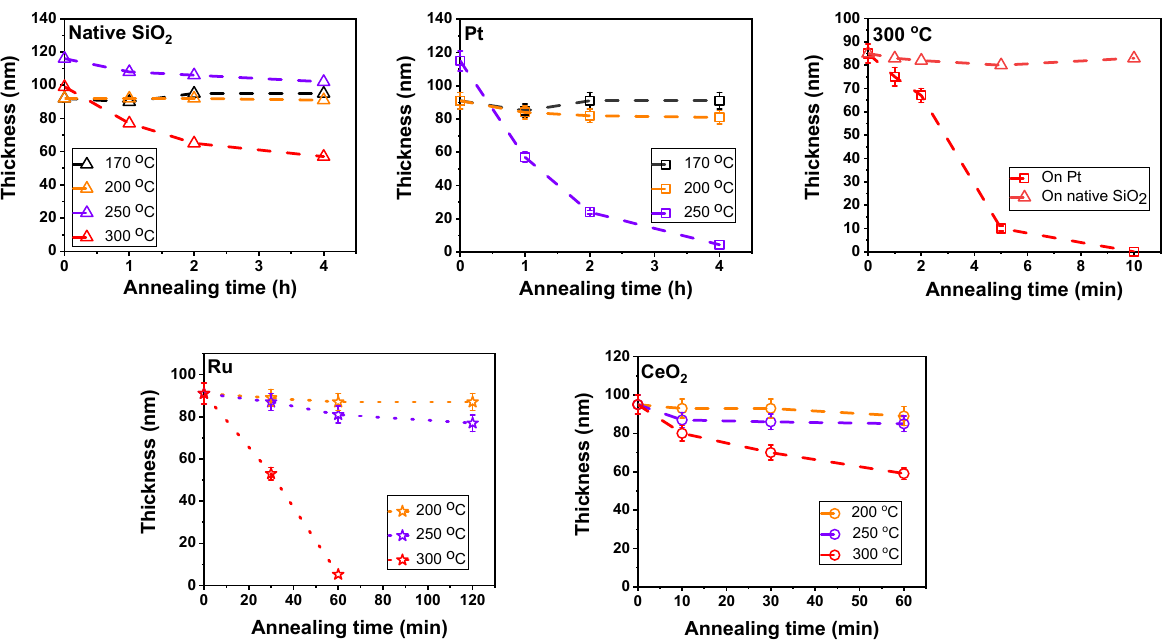
Figure 2. Polyimide film thicknesses on different surfaces versus annealing time in air.